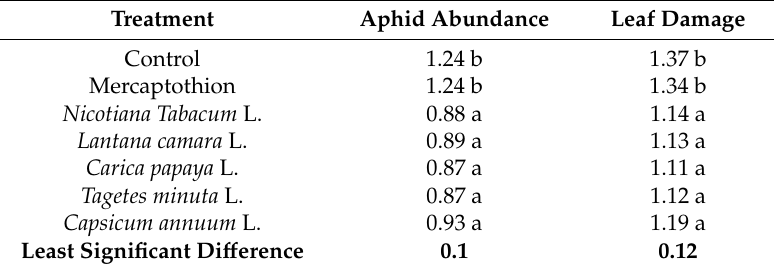
Table 3. Variation in aphid abundance and leaf damage of okra crops. Treatment